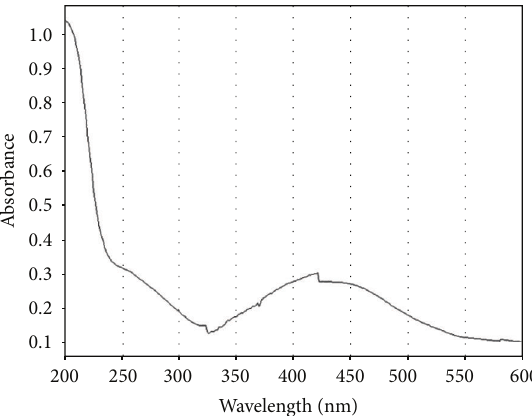
Figure 10: PVA electrostatic spun yarn with nanosilver colloid.